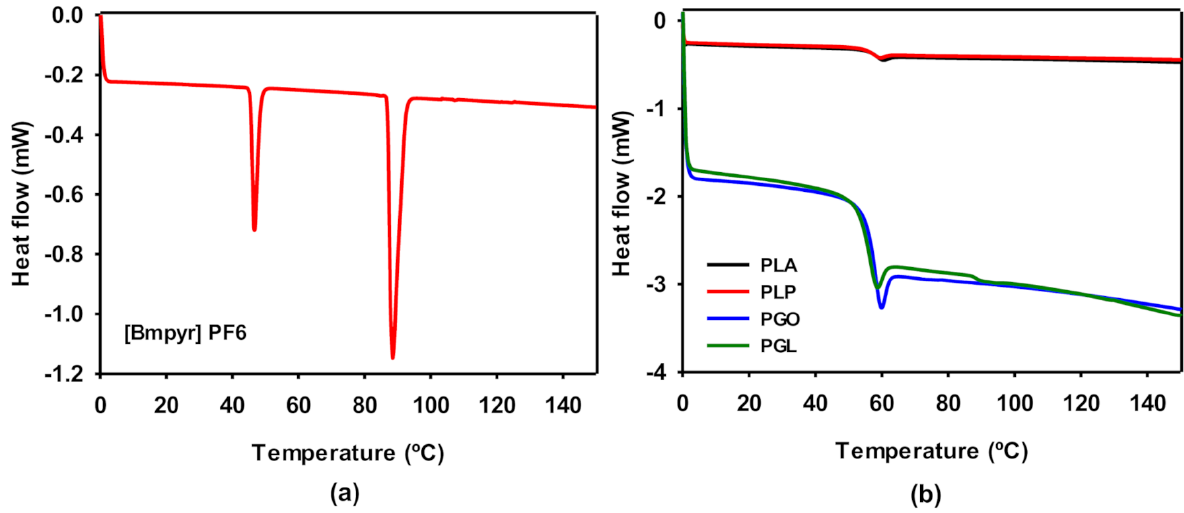
Figure 5. Differential scanning calorimetry (DSC) curves for [Bmpyr] PF6 ( a ) and for PLA, PLP, PGO, and PGL ( b